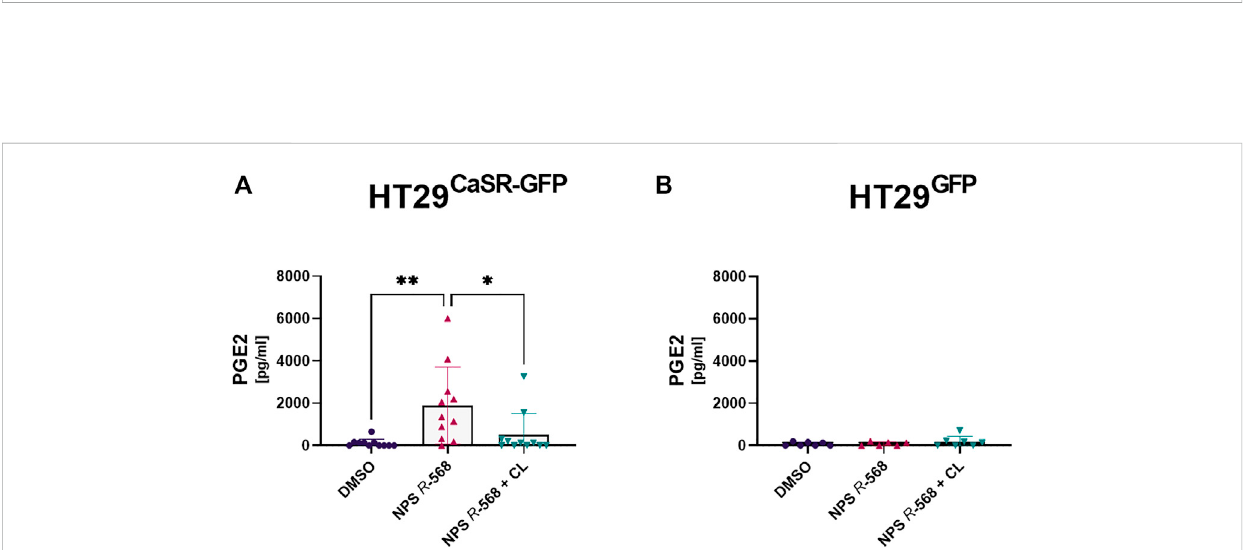
FIGURE 4 Induction and suppression of PGE 2 secretion by CaSR activation and inhibition. PGE 2 secretion in supernatant of (A) HT29 CaSR − GFP and (B) HT29 GFP after 4 htreatment with either vehiclecontrol(0.1%DMSO), 1 µMNPS R -568alone,ortogetherwith 1 µM ofthecalcilytic NPS 2143 (CL).Mean ±SD,N = 6 – 11, one-way ANOVA with Tukey ’ s post hoc test (0.1% DMSO), * p < 0.05, ** p <